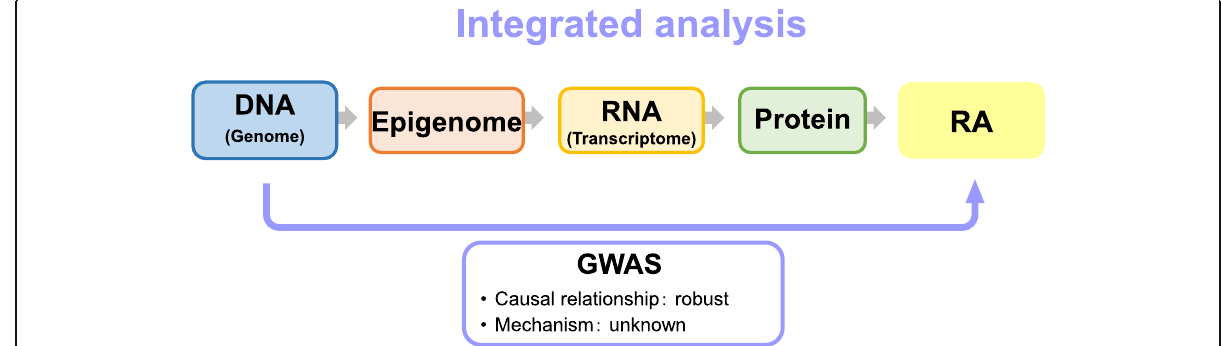
Fig. 1 The conceptual diagram of a genome-wide association study and an integrated analysis. GWAS, genome-wide association study